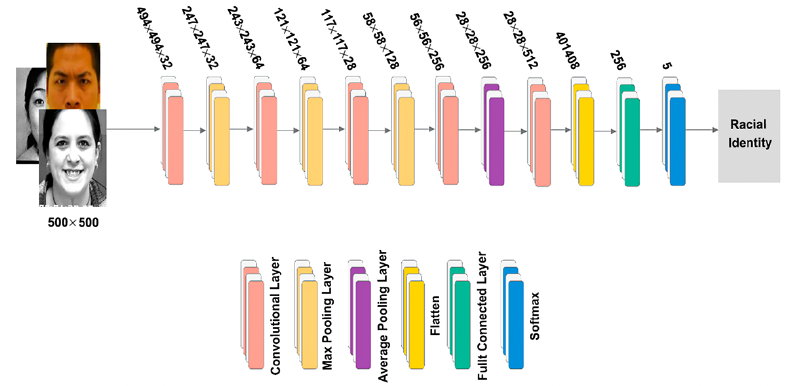
Figure 3. The proposed racial identity network (RI-Net)